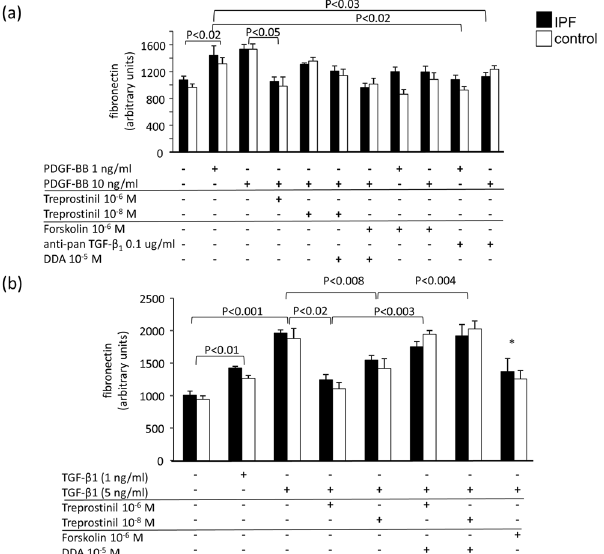
Figure 3. ( a ) Treprostinil inhibits PDGF-BB induced fibronectin deposition through TGF- β 1 and cAMP. ( b ) Treprostinil inhibits TGF- β 1 induced fibronectin deposition through cAMP signaling. Bars show the mean ± S.E.M. of triplicated experiments all primary control and IPF cell lines. Statistics: Mann-Whitney U-test.